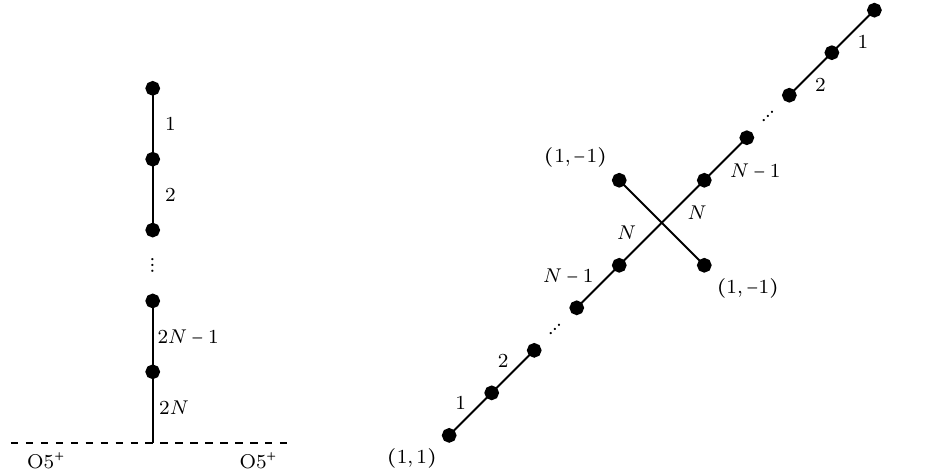
Figure 1. Brane webs engineering EQ 1 , 1 (left) and EQ 1 (right). The numbers near each 5-brane denote the number of coincident 5-branes in the stack in that segment. Black dots denote 7-branes of charge ( p,q )